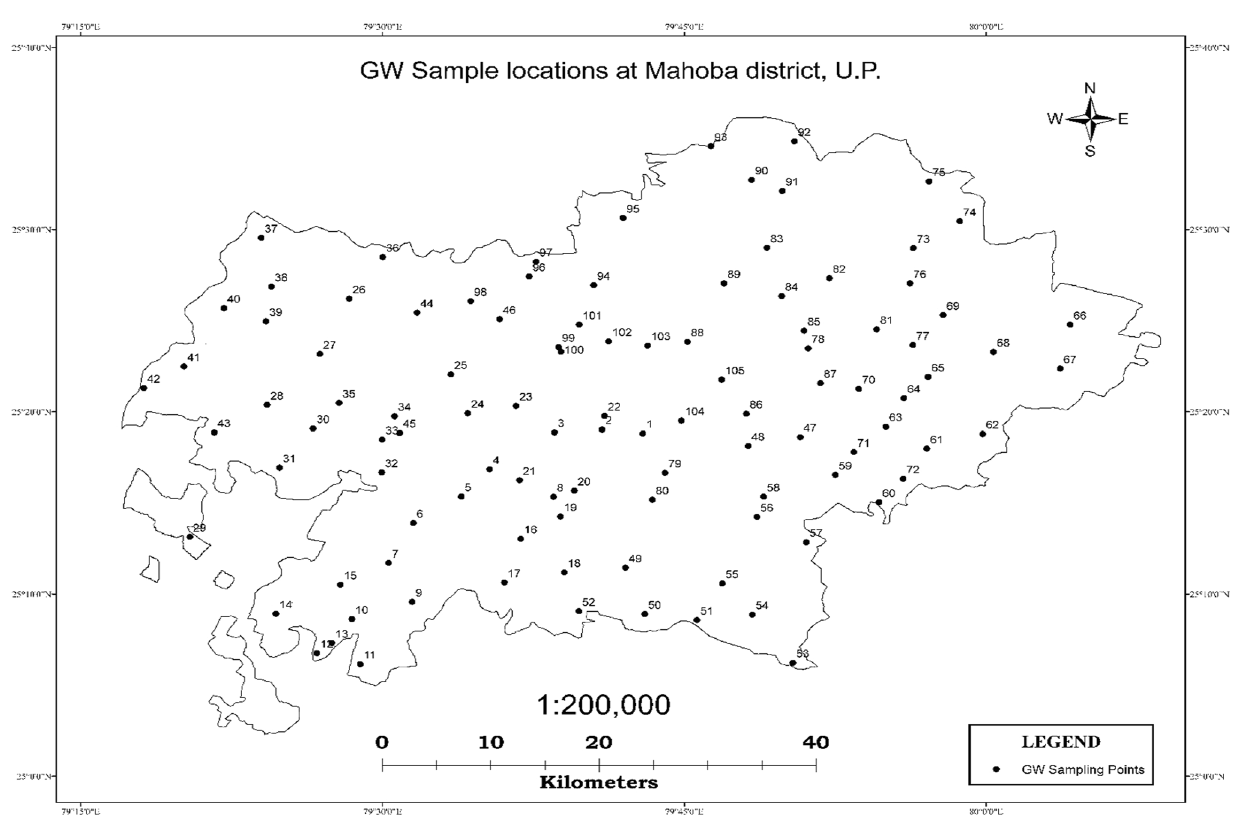
Fig. 3 Map displaying sampling locations at Mahoba